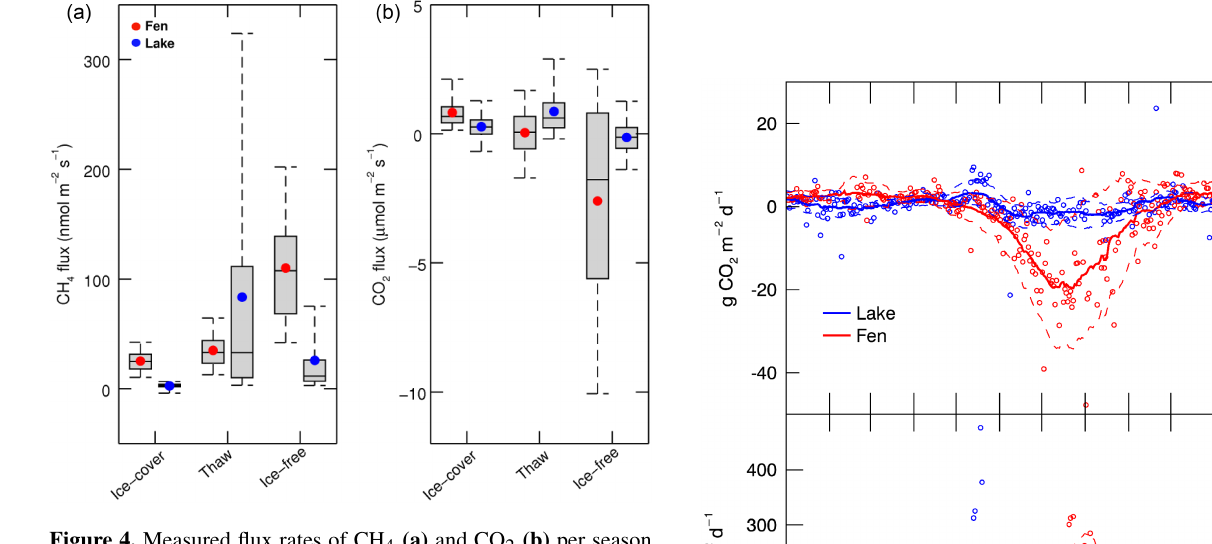
Figure 4. Measured flux rates of CH 4 (a) and CO 2 (b) per season and per ecosystem. The central line of the boxplots shows the me- dian, box edges show the 25th and 75th percentiles, and whiskers show the 5th and 95th percentiles. The black dots indicate the mean flux rate. Outliers are not displayed.